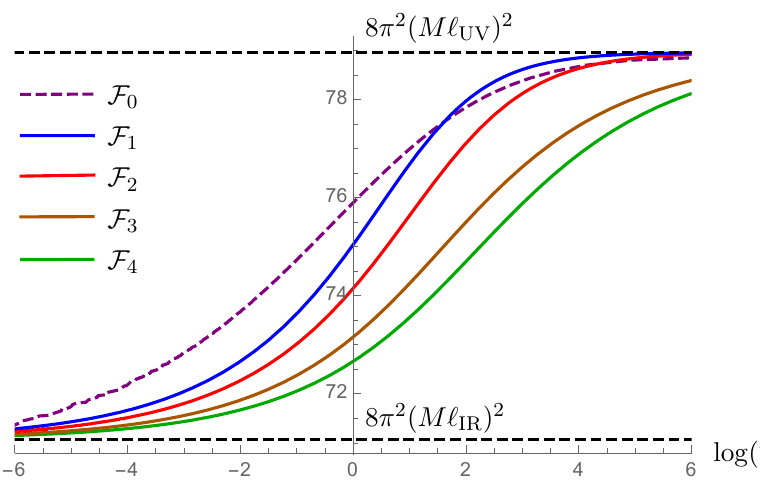
Figure 7. F -functions F 1 ; 2 ; 3 ; 4 de(cid:12)ned in (4.12){(4.15) and Liu-Mezei F -function F 0 (i.e. the REE of [18]) vs. log( R ) for a holographic model with dilaton potential (4.31) and (cid:1) (cid:0) = 1 : 2. to obtain a solution for the functions W ( ’ ), S ( ’ ) and U ( ’ ). From the